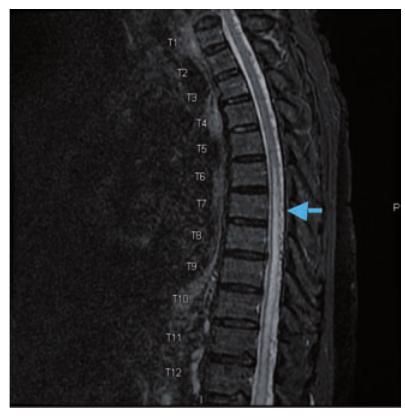
Figure 9. STIR image of the thoracic spine demonstrate hyper intense T2 signal abnormality within the central area of the thoracic spinal cord extending from T6 to the conus medullaris (arrow).